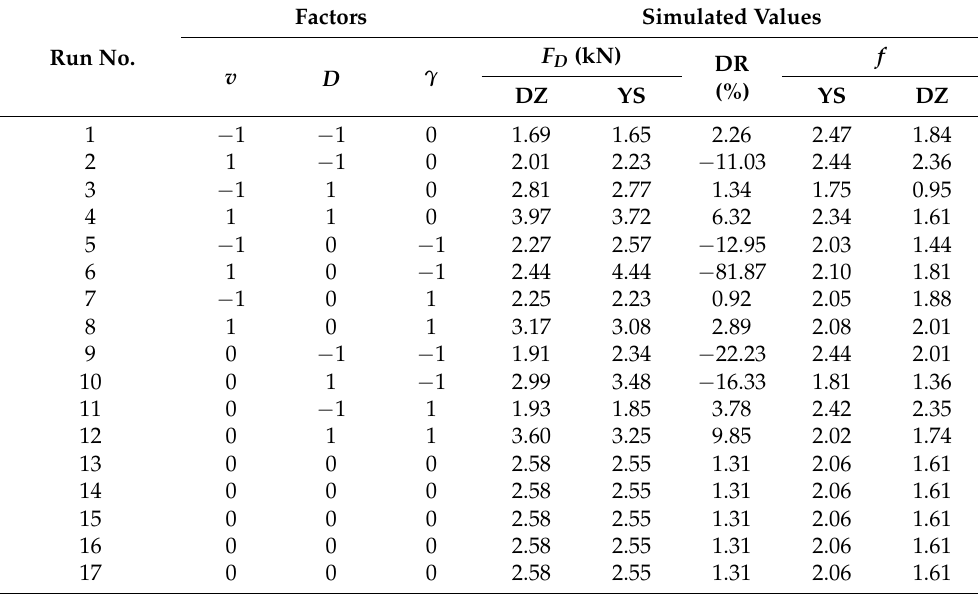
Table 4. Experimental scheme and the simulated results for single shovels.